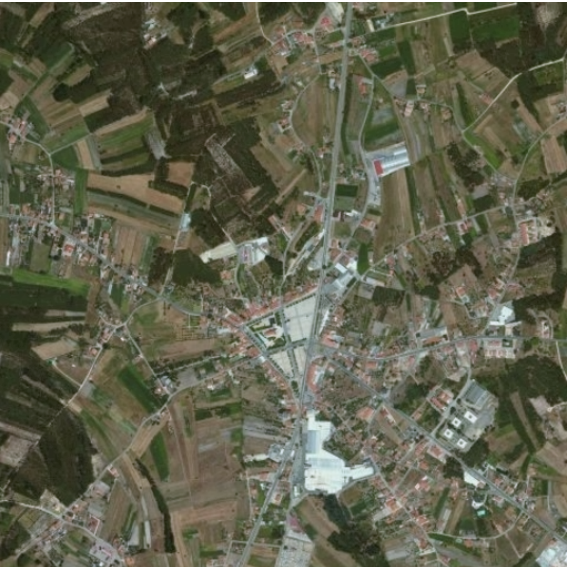
Figure 3. Example of panchromatic and multispectral satellite image fusion on an image from MASATI dataset v2 [3] which is available for the scientific community on demand at http://www.iuii.ua.es/datasets/masati (accessed on 8 November